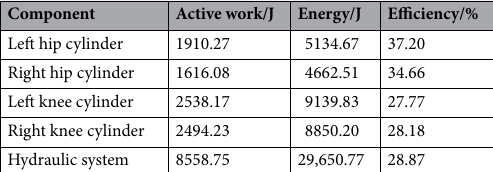
Table 4. Active work and energy consumption after optimization.